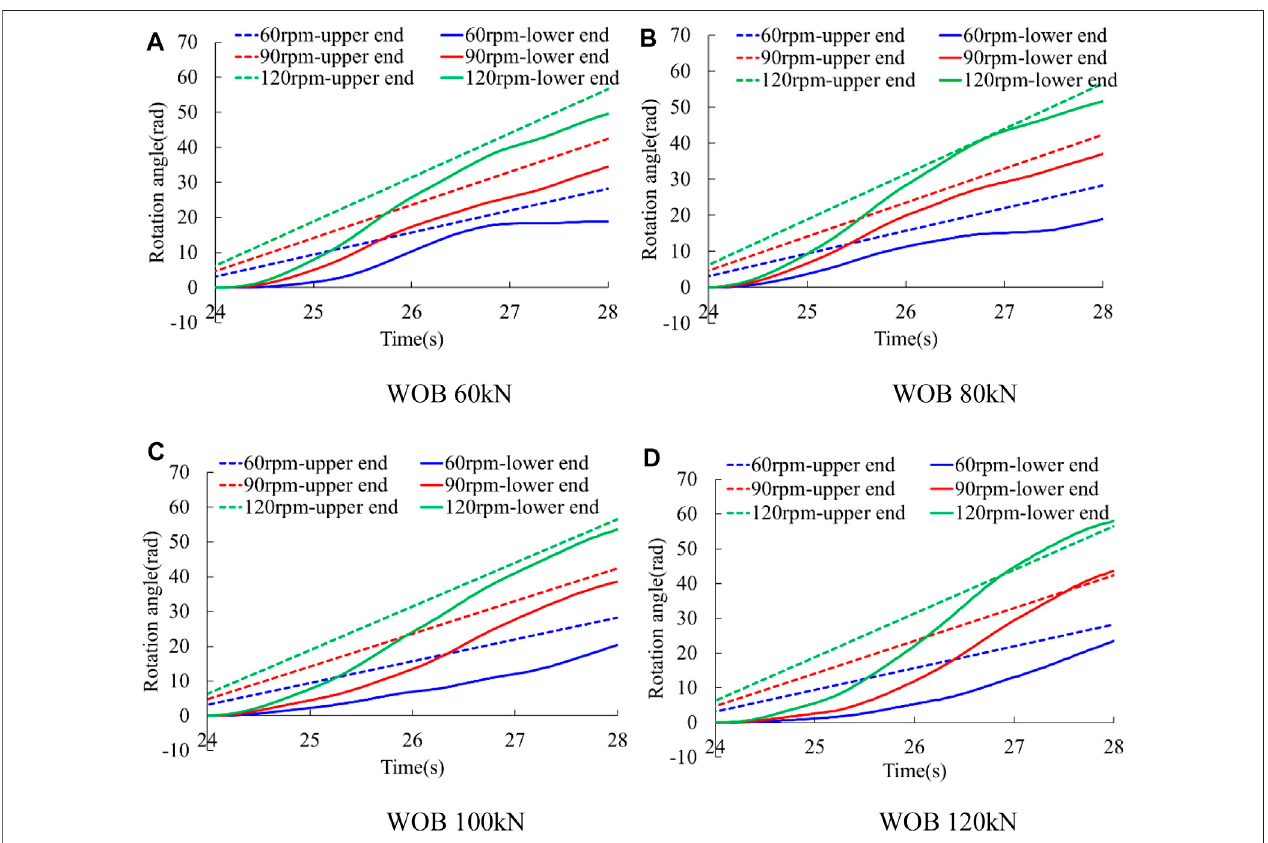
FIGURE 10 | Rotation angle at the upper end and the lower end of drill string. (A) WOB 60 kN (B) WOB 80 kN (C) WOB 100 kN (D) WOB 120 kN.